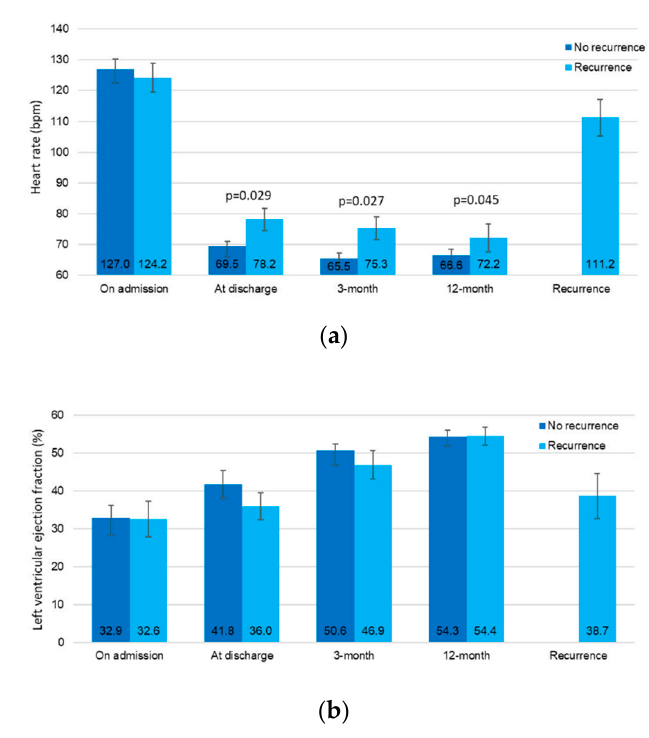
Figure 3. The mean values of the heart rate ( a ) and let ventricular ejection fraction ( b ) during follow-up, according to the presence or absence of future recurrences.